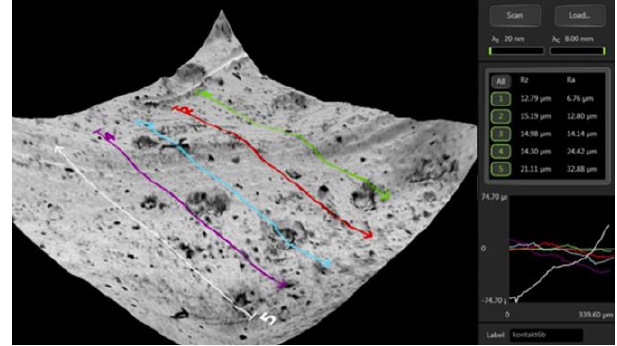
Fig. 13. Sample number 3, measurement 2 – 3D view of the test surface